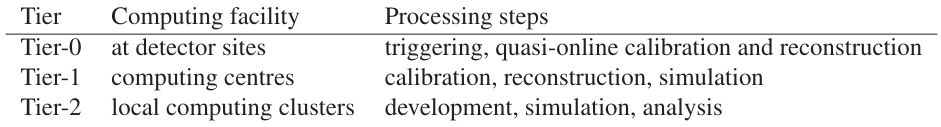
Table 2. Data processing steps performed on di ff erent tier-structured computing facilities.